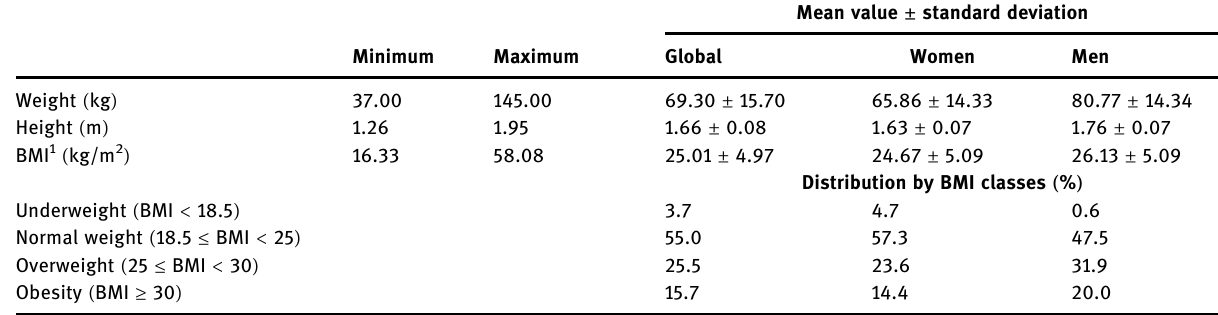
Table 1: Anthropometric characteristics of the participants